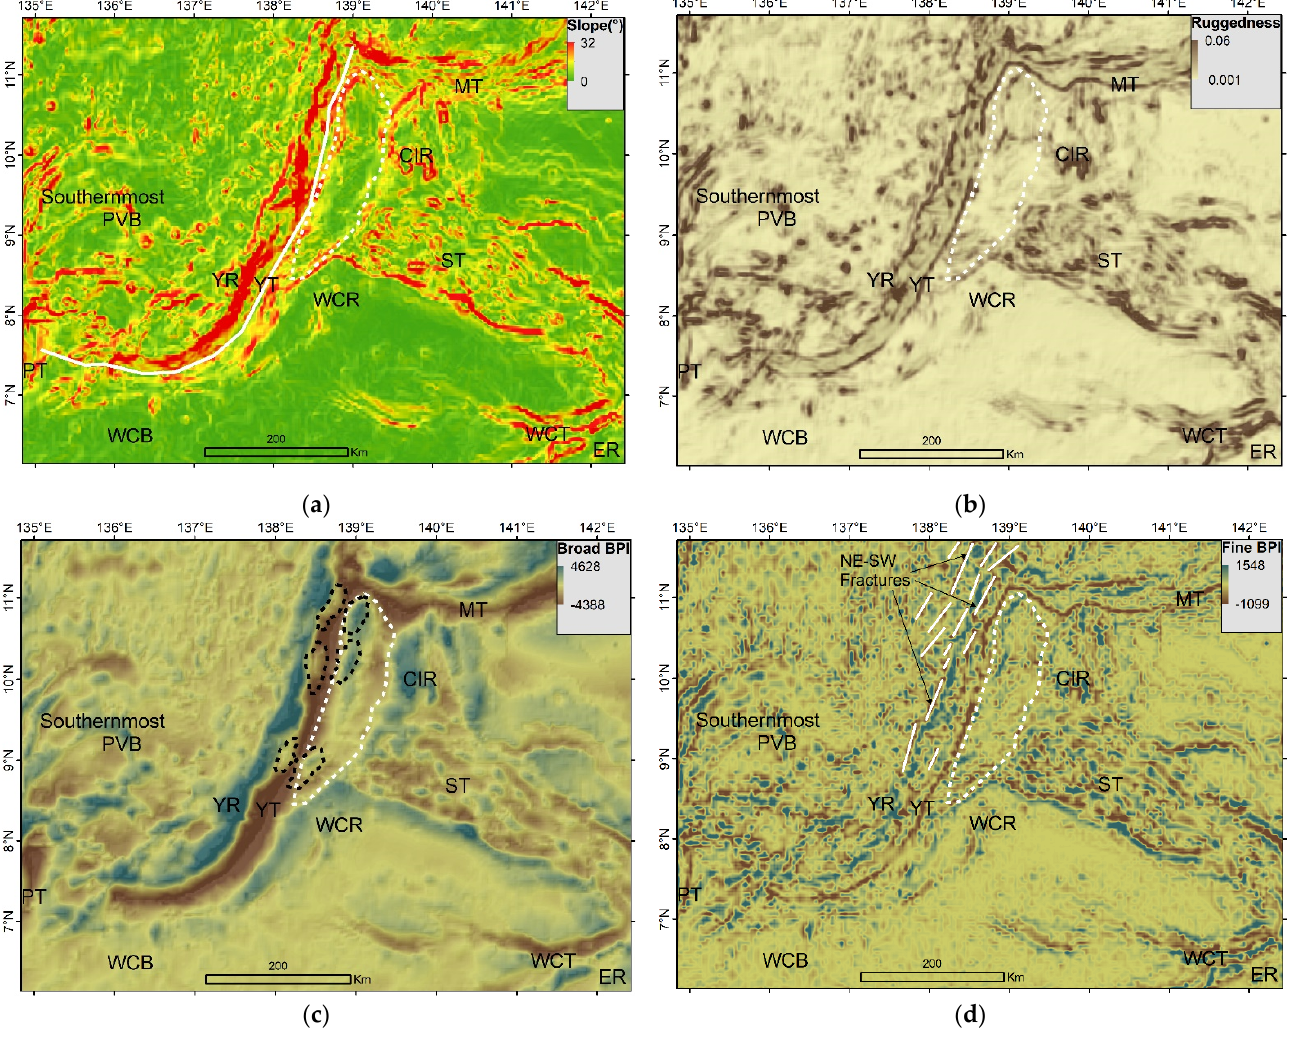
Figure 5. The general geomorphological characteristics of the YSZ. ( a ) Slope (degrees); ( b ) ruggedness; ( c ) broad BPI; ( d ) fine BPI. The white dashed polygon delineates the zone of horst and graben structures. The black dashed polygons outline the correlated bathymetry highs on the arc-ward and seaward trench slopes. The J-shaped solid white line delineates the YT axis. See Figure 1 for abbreviations.